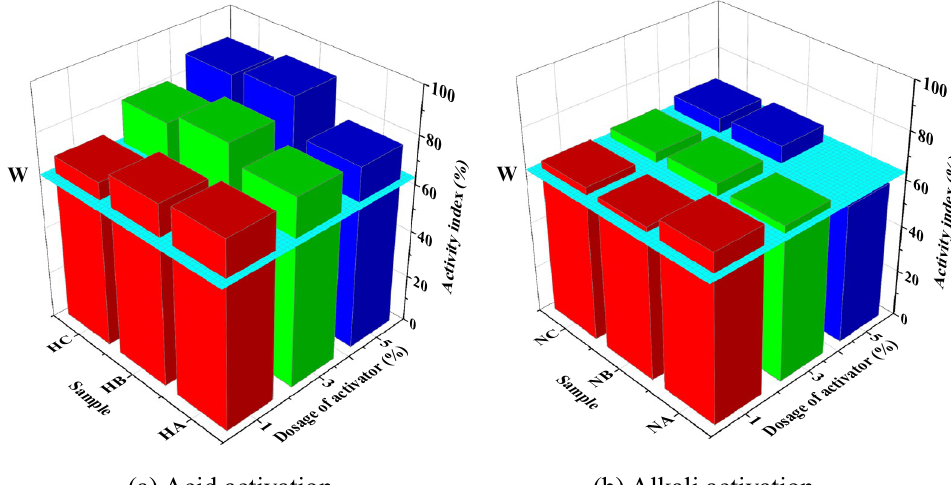
Fig. 14 Activity index of cement mortar with single-activated iron tailings powder